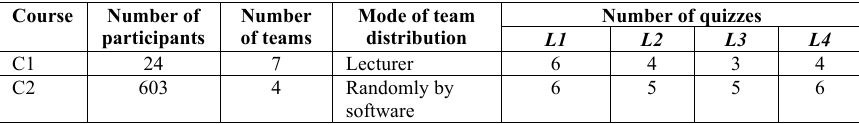
Table 1. Overview of the utilization of the team component in C1 and C2. L1, L2, L3, and L4 describe the time-sorted lectures in which the team-based social gamification was used. Course Number of Number Mode of team participants of teams